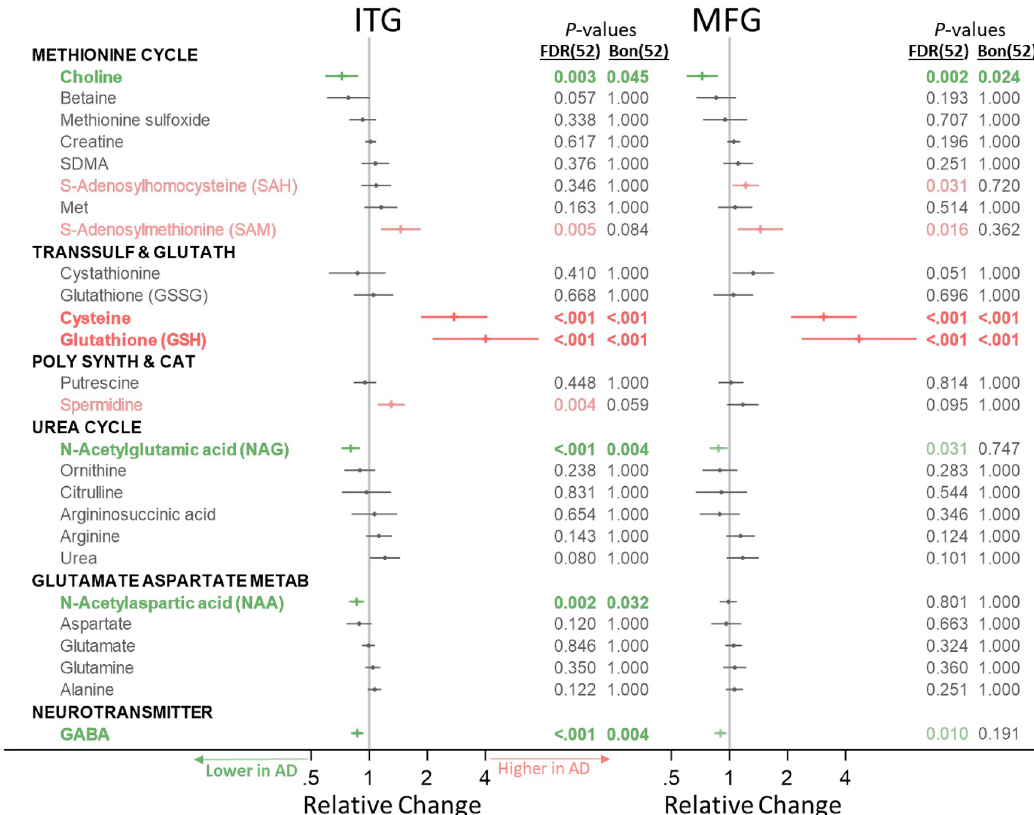
Fig 1. Group differences in category-specific metabolite concentrations. Metabolites in green or red (not bold) were significant after FDR correction for 52 comparisons; metabolites in green or red (bold) were also significant after Bonferroni correction for 52 comparisons. Differences in metabolite concentration across groups were tested using linear mixed-effects models for each metabolite category. AD, Alzheimer disease; Bon, Bonferroni; FDR, false discovery rate; Glutamate Aspartate Metab, glutamate- aspartate metabolism; ITG, inferior temporal gyrus; MFG, medial temporal gyrus; Poly Synth & Cat, polyamine synthesis and catabolism; Transsulf and Glutath, transsulfuration and glutathione